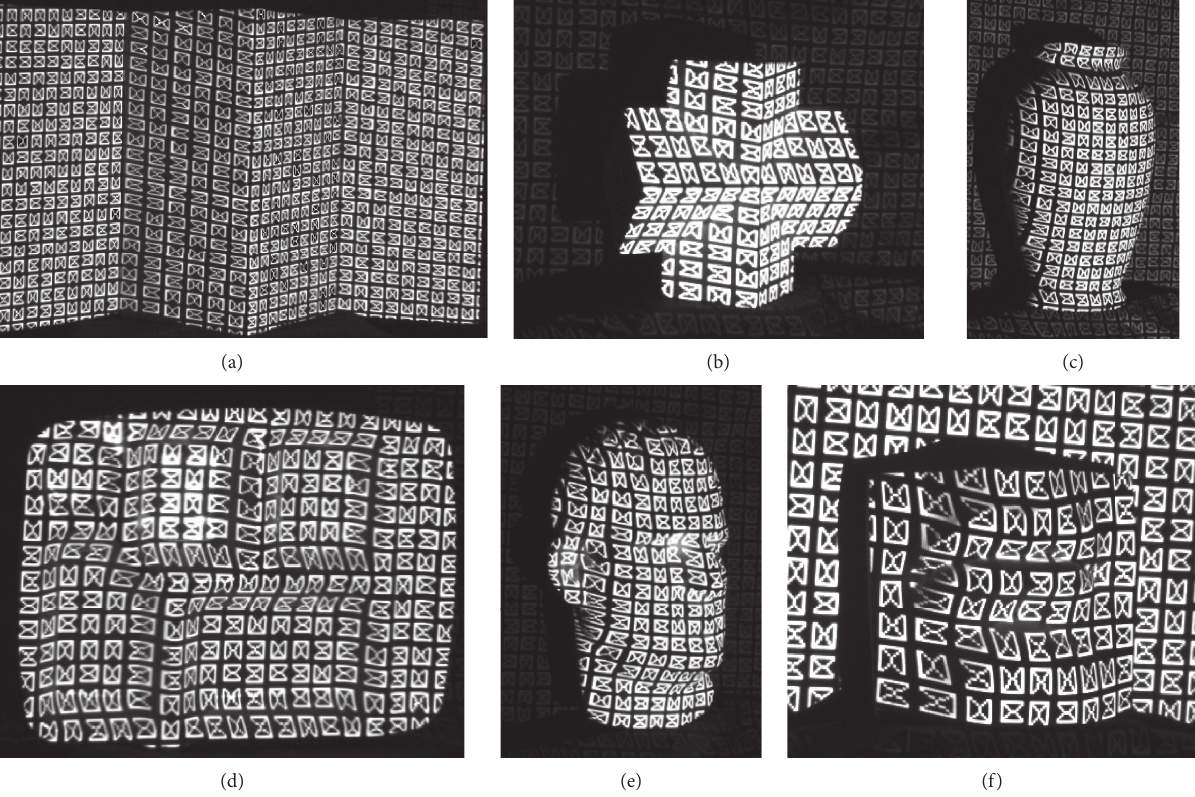
Figure 14: The deformed patterns of projecting the pattern on the objects captured by the camera for (a) four-stairs, (b) polygon, (c) yellow bottle, (d) tableware, (e) head model, and (f) mouth model.